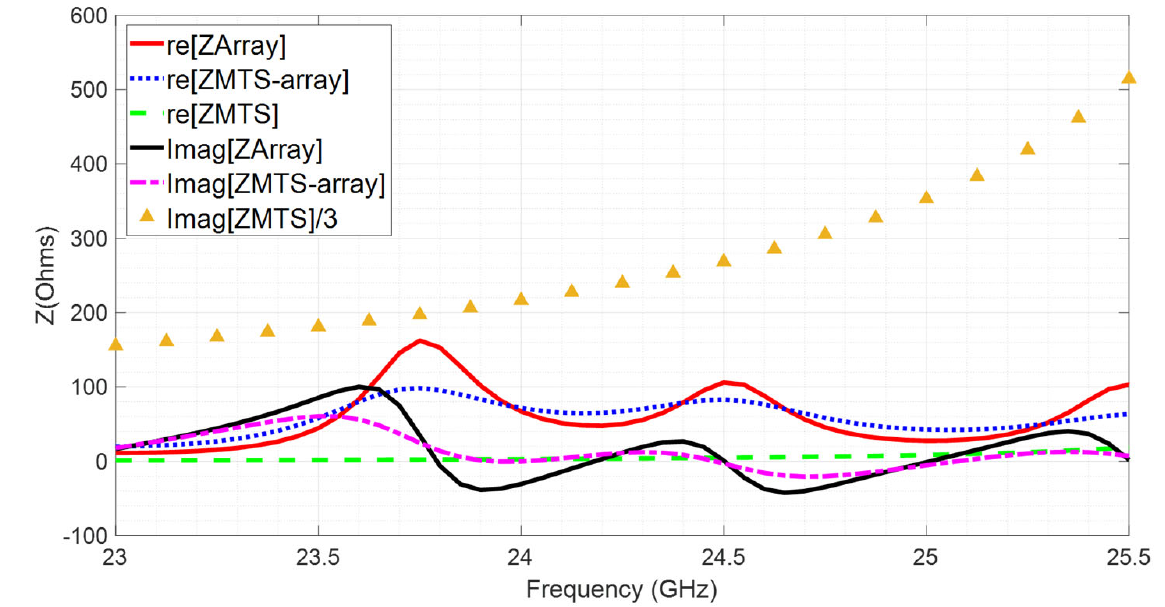
Figure 11. Impedance of the array, the MTS–array combination and the MTS versus frequency.